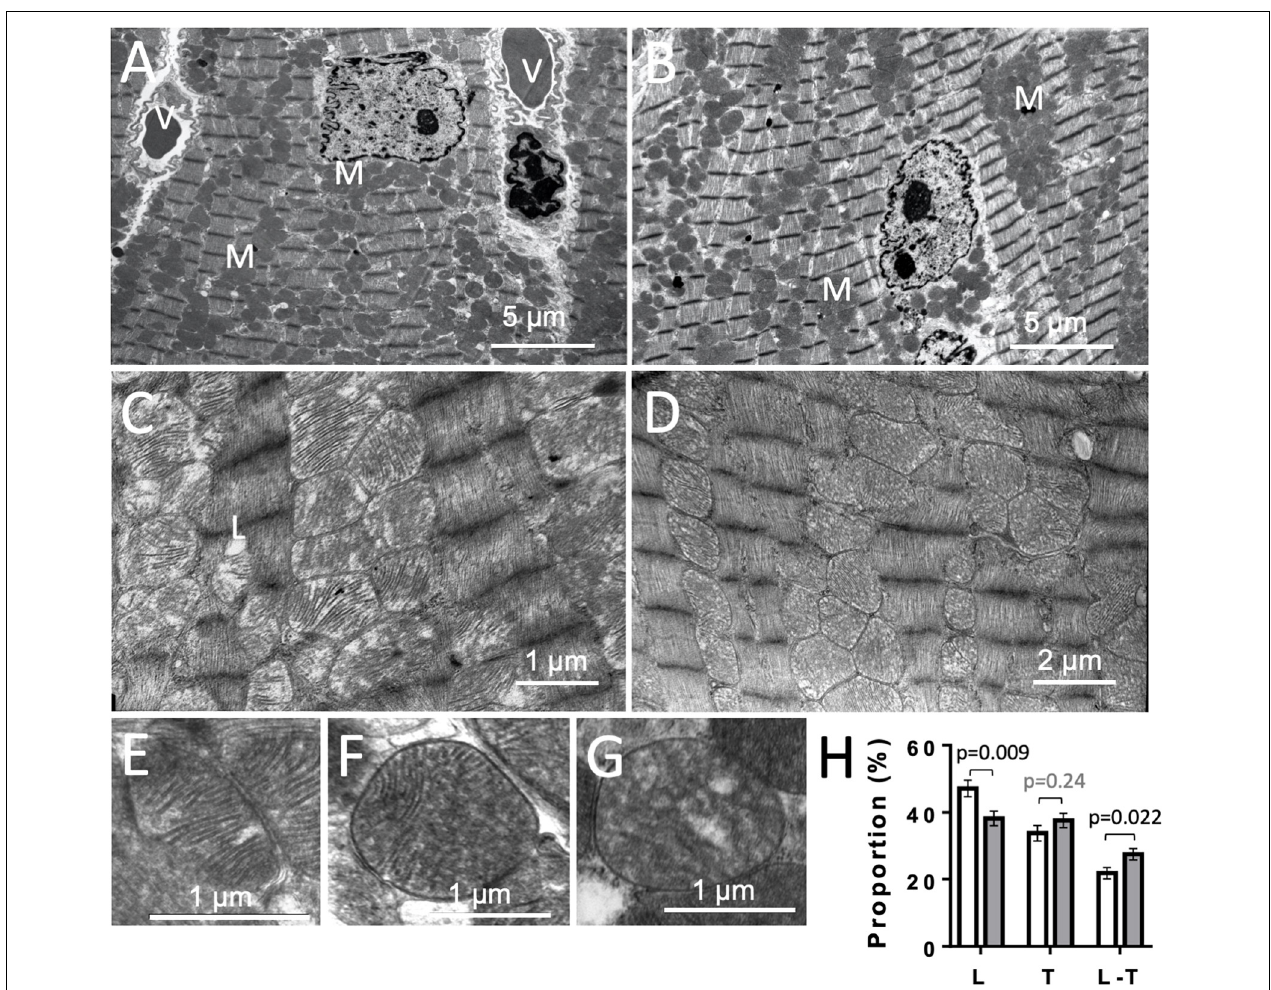
FIGURE 9 | Cardiac ultrastructure in control and AMPK α 1 α 2-KO mice. (A,B) Panoramic electron microscopy view of a control (A) and AMPK α 1 α 2-KO (B) myocardium 10–16 weeks after tamoxifen administration. M, mitochondria; V, vessel. (C,D) Pleomorphic mitochondria in control (C) and AMPK α 1 α 2-KO (D) hearts. (E–H) The three basic morphologies of mitochondrial cristae: lamellar (E) , mixed lamellar-tubular (F) and tubular (G) and their prevalence in control and AMPK α 1 α 2-KO myocardium (H) . Mitochondrial cristae morphometry was realized on 1291 mitochondria (651 for control and 640 for KO mice) on 46 and 39 micrographs from control KO mice ( n = 6 control and 3 KO). Each mitochondrion was classified into one of the following morphological categories: tubular T, lamellar L, or mixed (lamellar-tubular L-T); control (white bar), KO (gray bar). The relative percentage of the three basic morphologies was calculated; comparisons were done using t